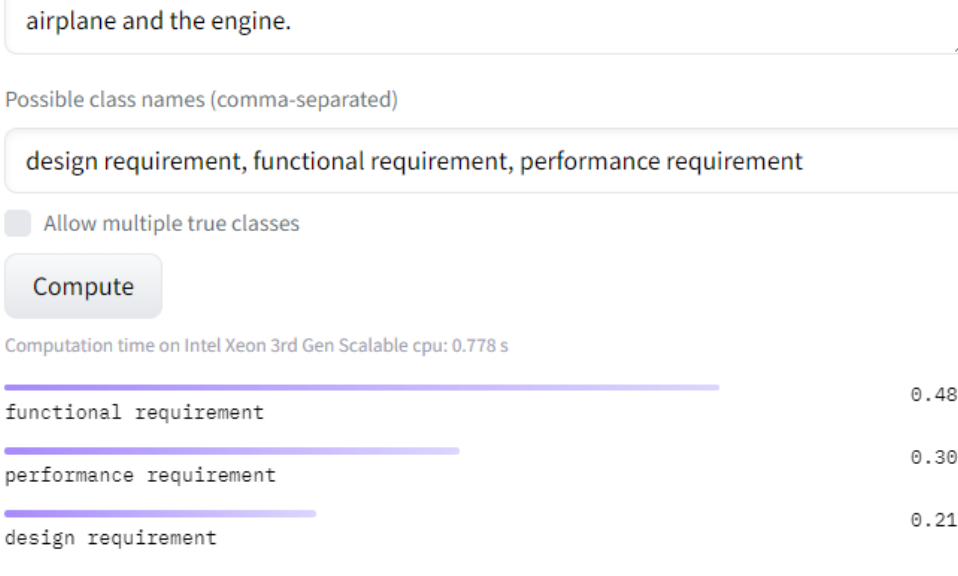
Figure 4. Classification of a performance requirement by the bart-large-mnli model